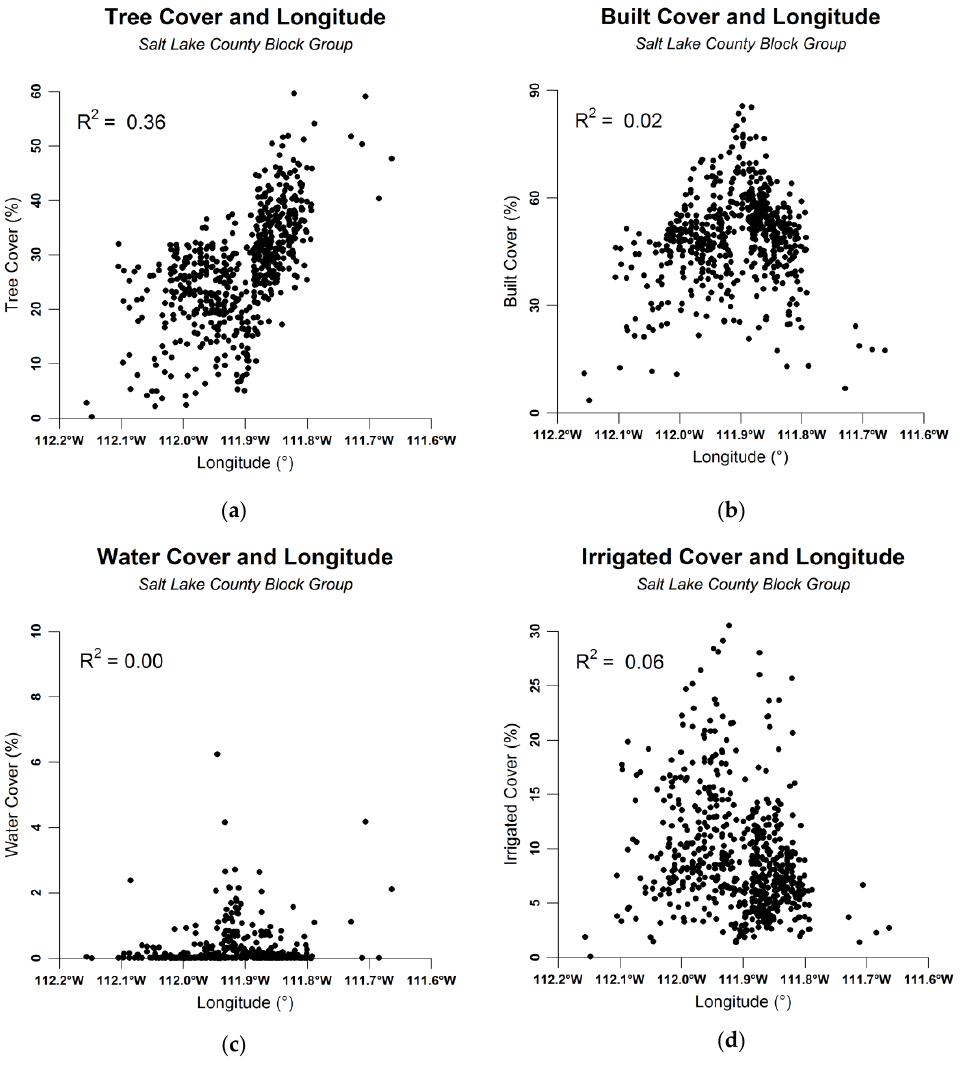
Figure 2. Longitudinal distribution of various land cover categories at the block group level: ( a ) Trees; ( b ) Built; ( c ) Water; and ( d )